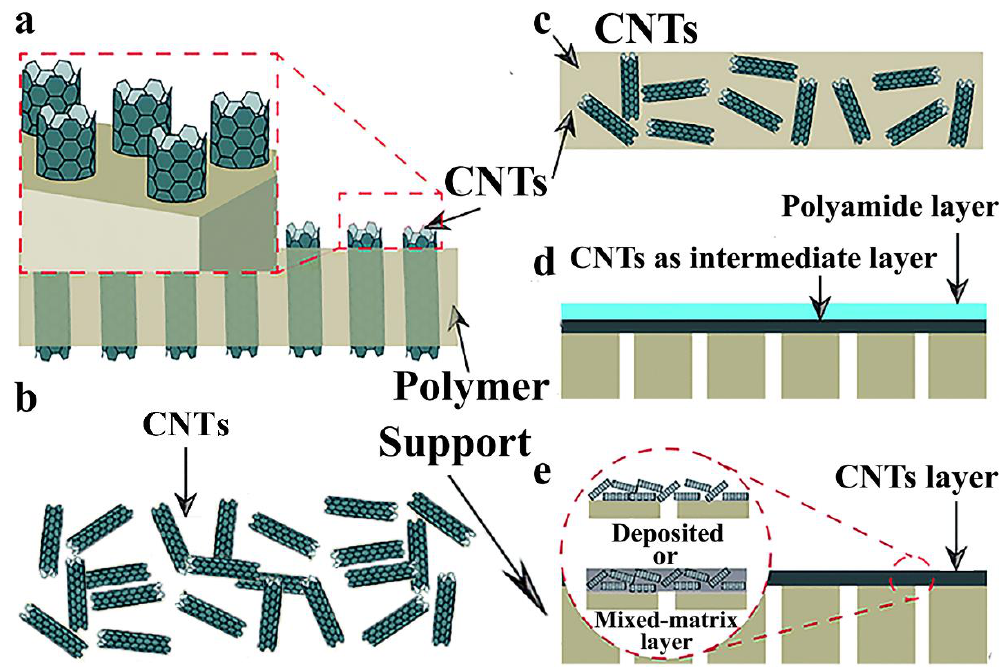
Figure 1. Carbon nanotubes (CNT) membranes with various structures. Freestanding CNT membranes: ( a ) vertically aligned CNT (VACNT) membranes, ( b ) buckypaper CNT membranes; composited CNT membranes: ( c ) mixed-matrix CNT membranes, ( d ) membranes with CNTs coated on the membrane surface (support) as the intermediate layer, ( e ) membranes with CNTs coated on its surface or support (Reproduced or adapted from ref. [24], with permission from The Royal Society of Chemistry, 2017).